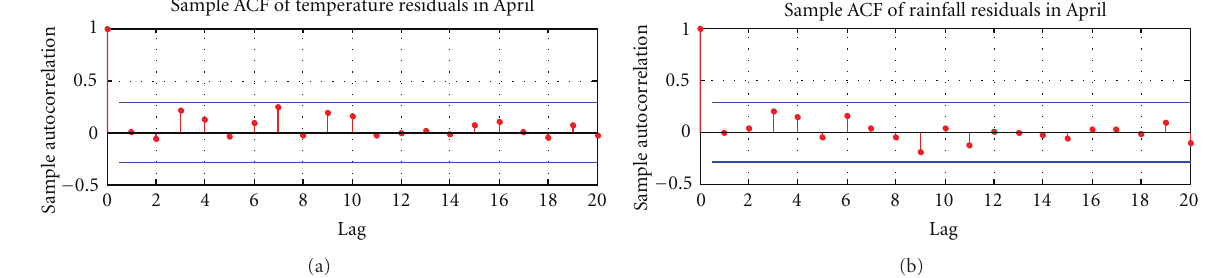
Figure 5: Sample autocorrelation function (ACF) of AR adjusted temperature and rainfall in